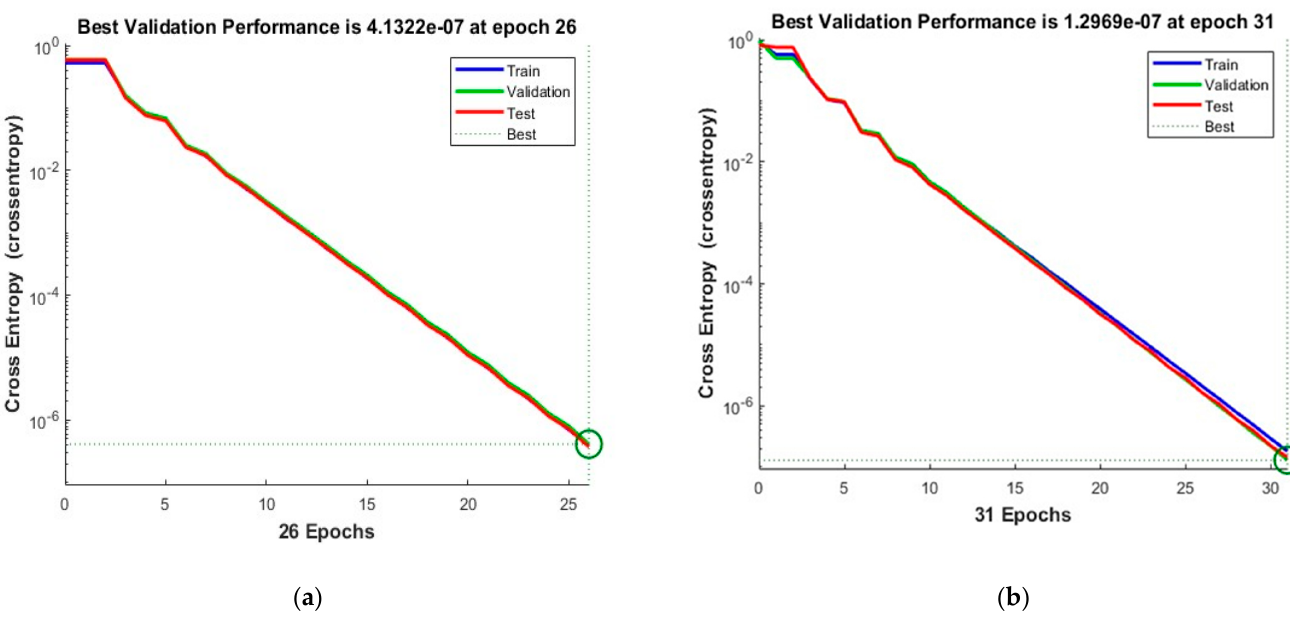
Figure 10. The convergence of the neural network for Dataset-3. ( a ) 10 Neurons and ( b ) 50 Neurons in the hidden layers.